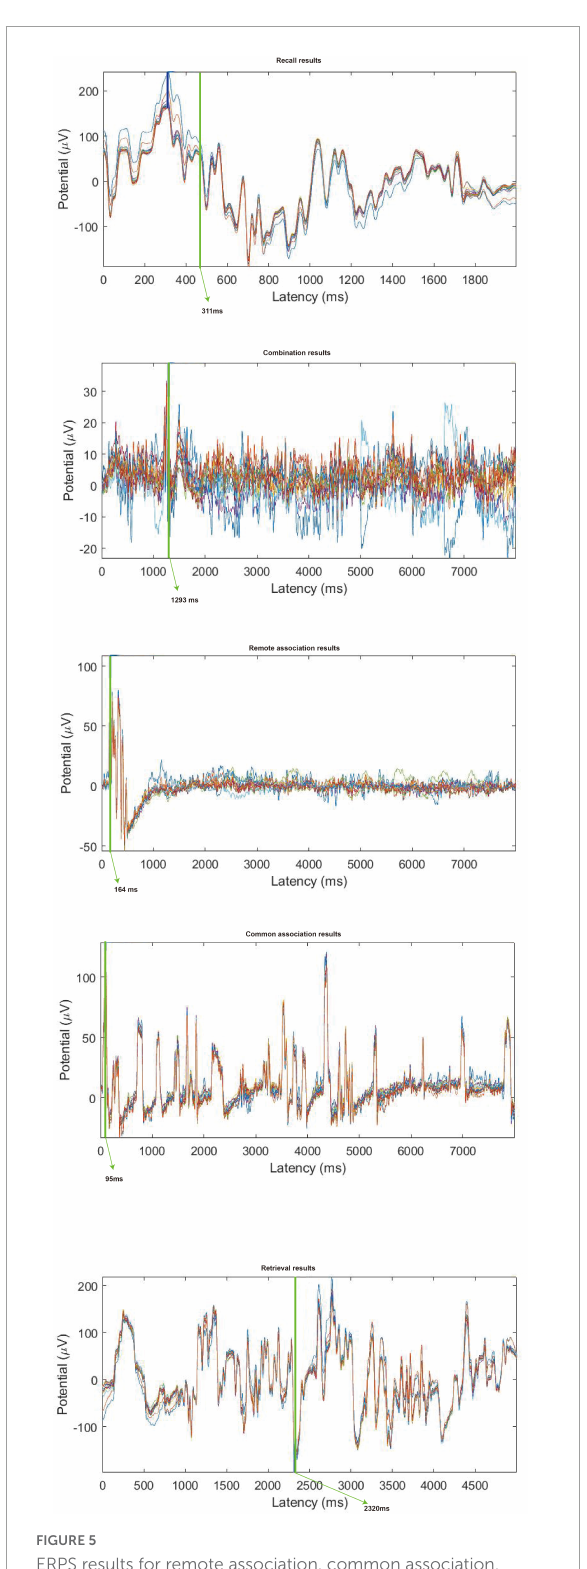
FIGURE5 ERPS results for remote association, common association, recall, retrieval, and combination induction tasks.